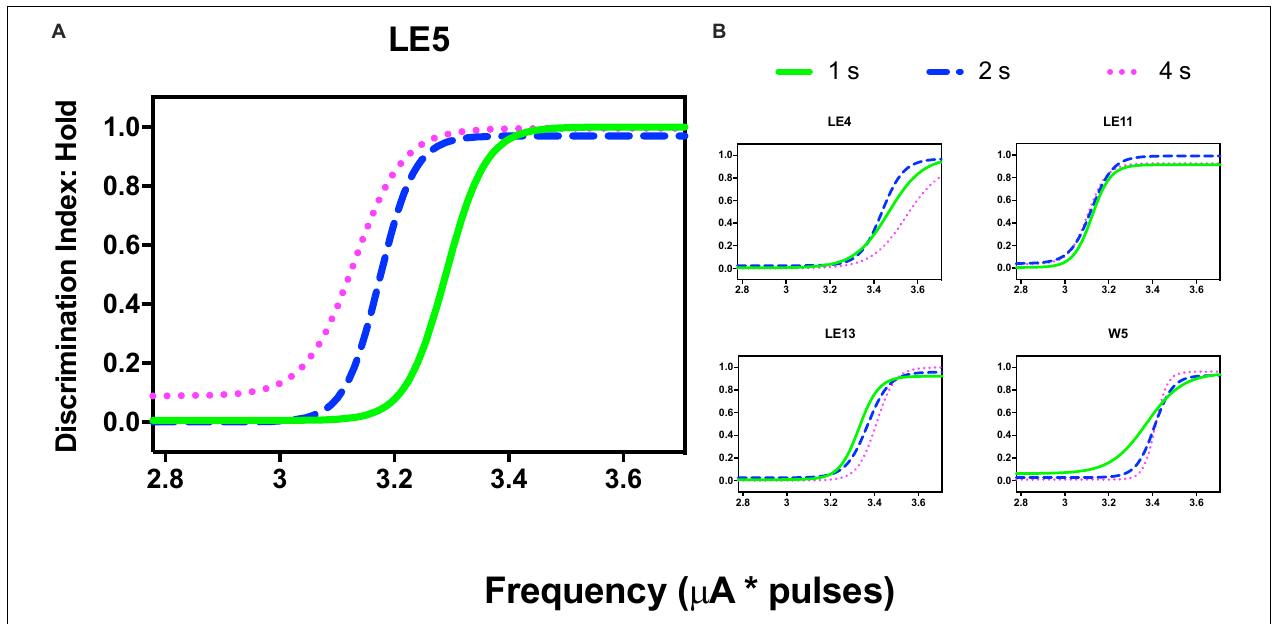
FIGURE 9 | Discrimination Index (DI) as a function of variations of frequency (in common scale, see text) and price (hold requirements). Abscissas in log scale. (A) Exemplar rat. (B) Remaining rats.